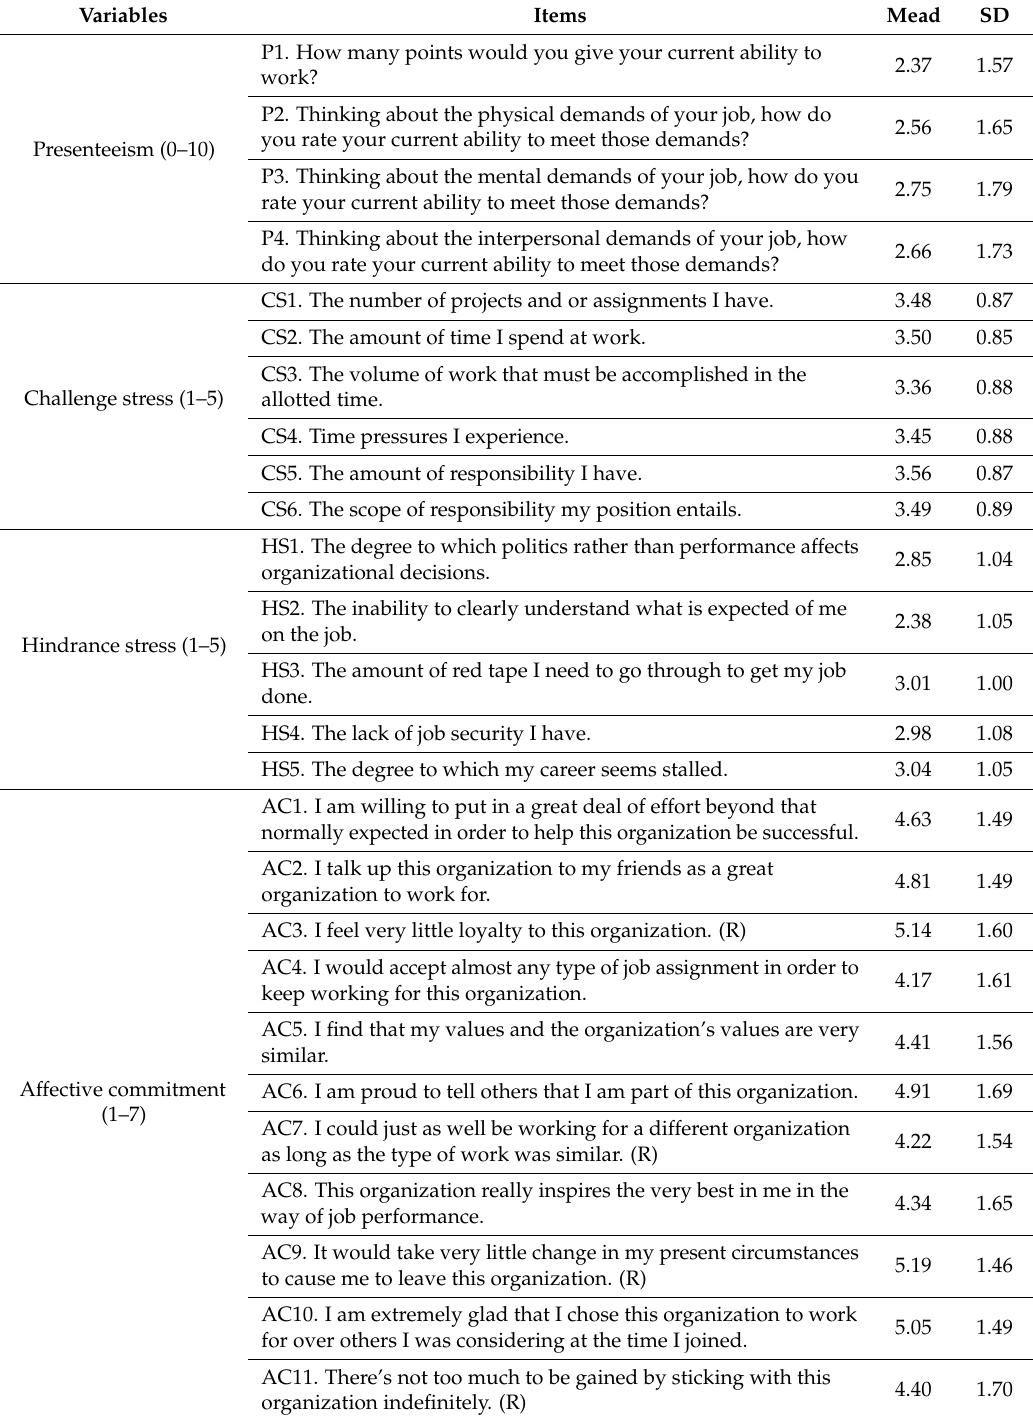
Table 1. Means (SD) for presenteeism (P), challenge stress (CS), hindrance stress (HS), and affective commitment (AC)